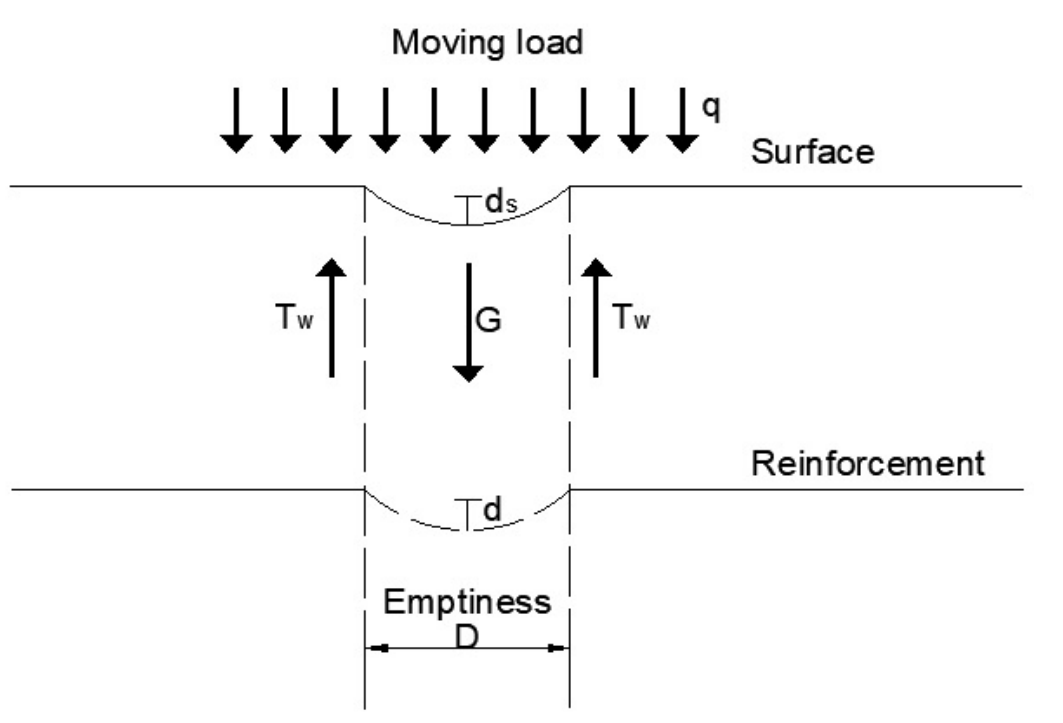
Figure 2. RAFAEL model–sketch. D—sinkhole diameter, d—diaphragm deflection, d s —road surface deflection, q—load, T w —sidewall friction force, G—ground weight Adapted from [38]. Table 1. List of exemplary parameters of the applied geosynthetics. Aramid